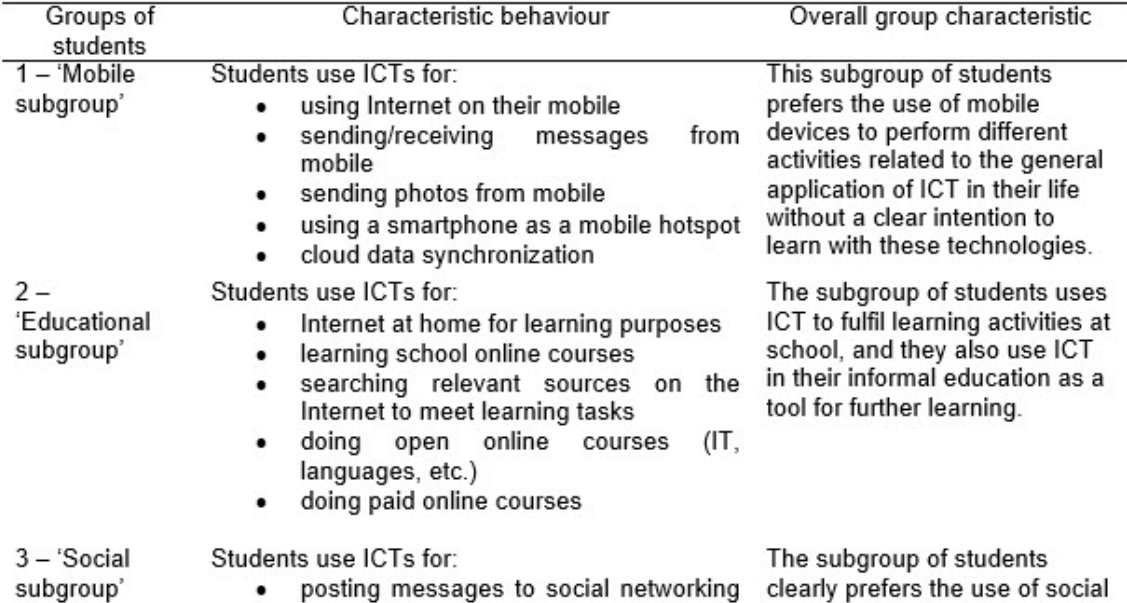
Characteristic behaviours of subgroups of